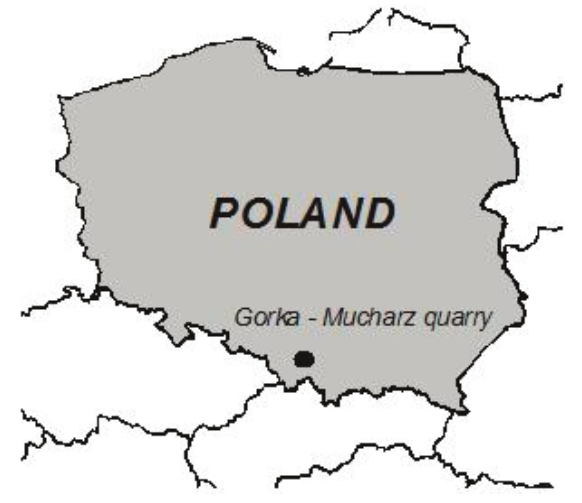
Fig. 1. Location of the Górka–Mucharz